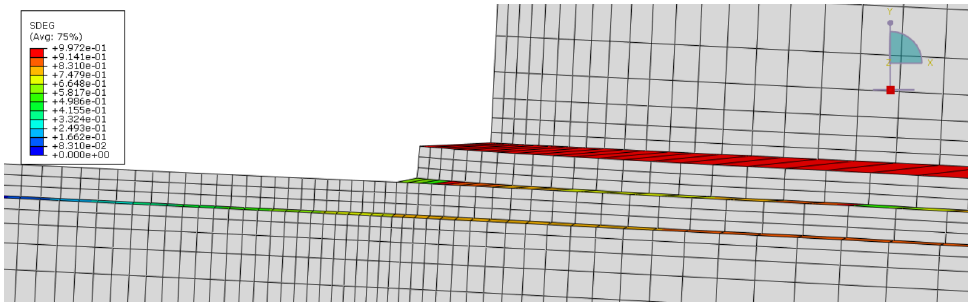
Figure 28. Simulated failure